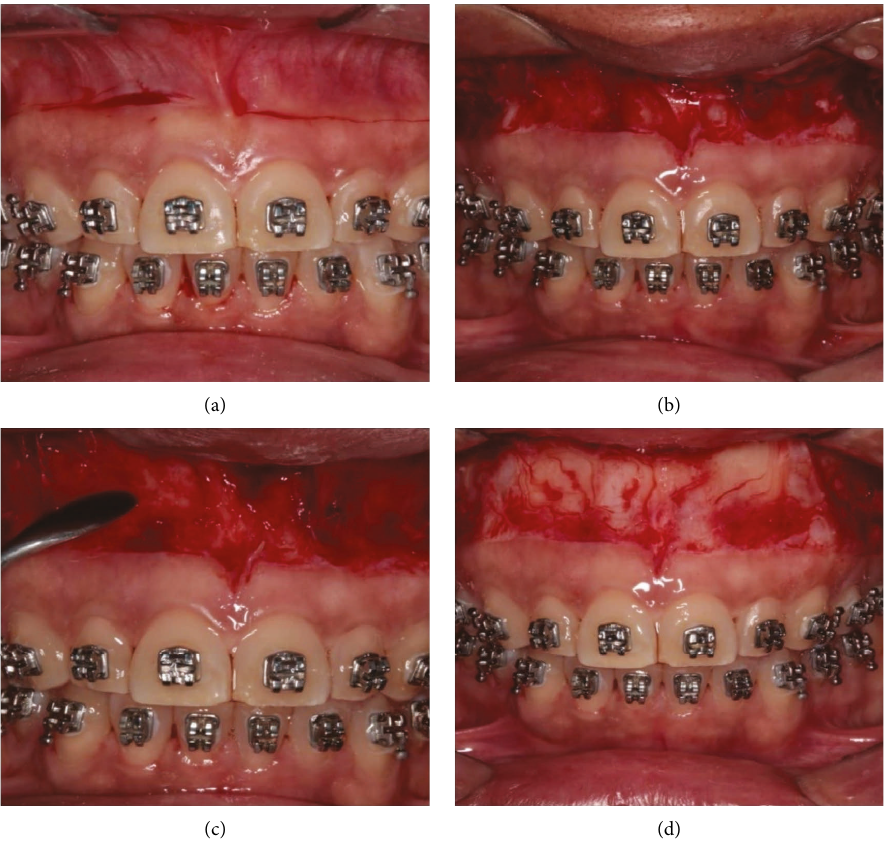
Figure 3: (a) Demarcation of the incision lines. (b) Tissue remotion. (c) Muscle detachment in the direction of its insertion origin. (d) Muscle away maintaining a periosteum band for the